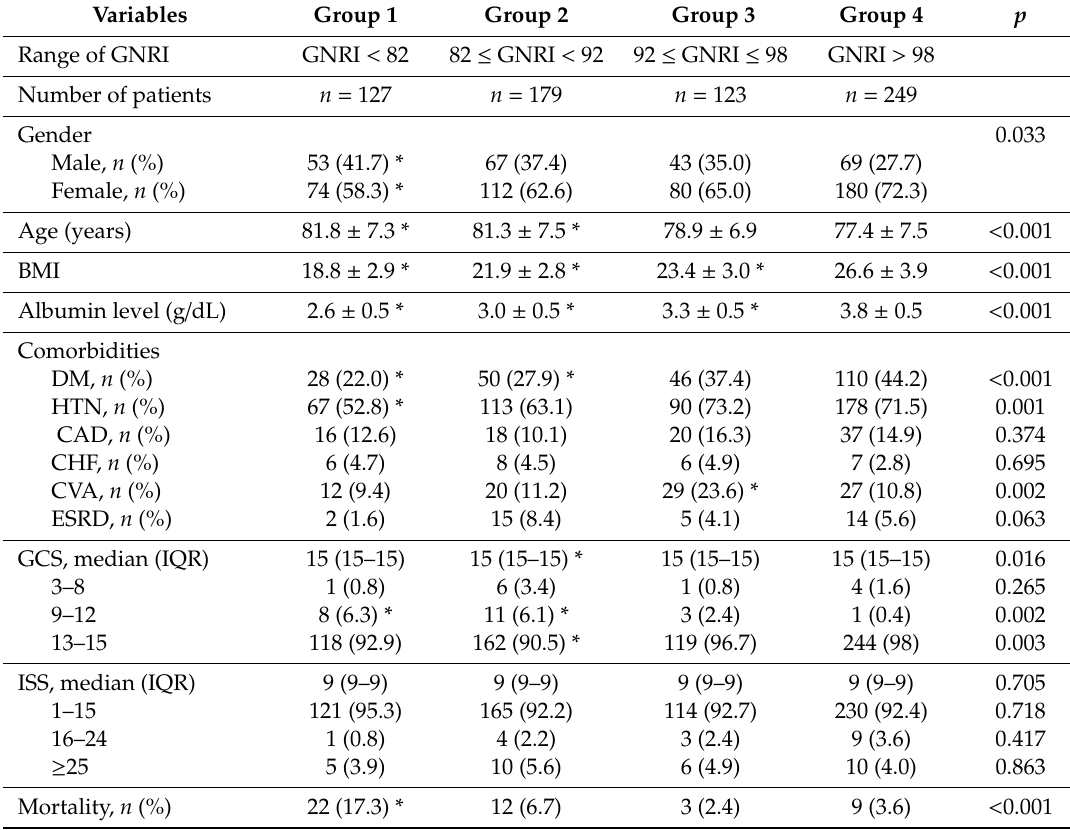
Mortality, n (%) 22 (17.3) * 12 (6.7) 9 (3.6) <